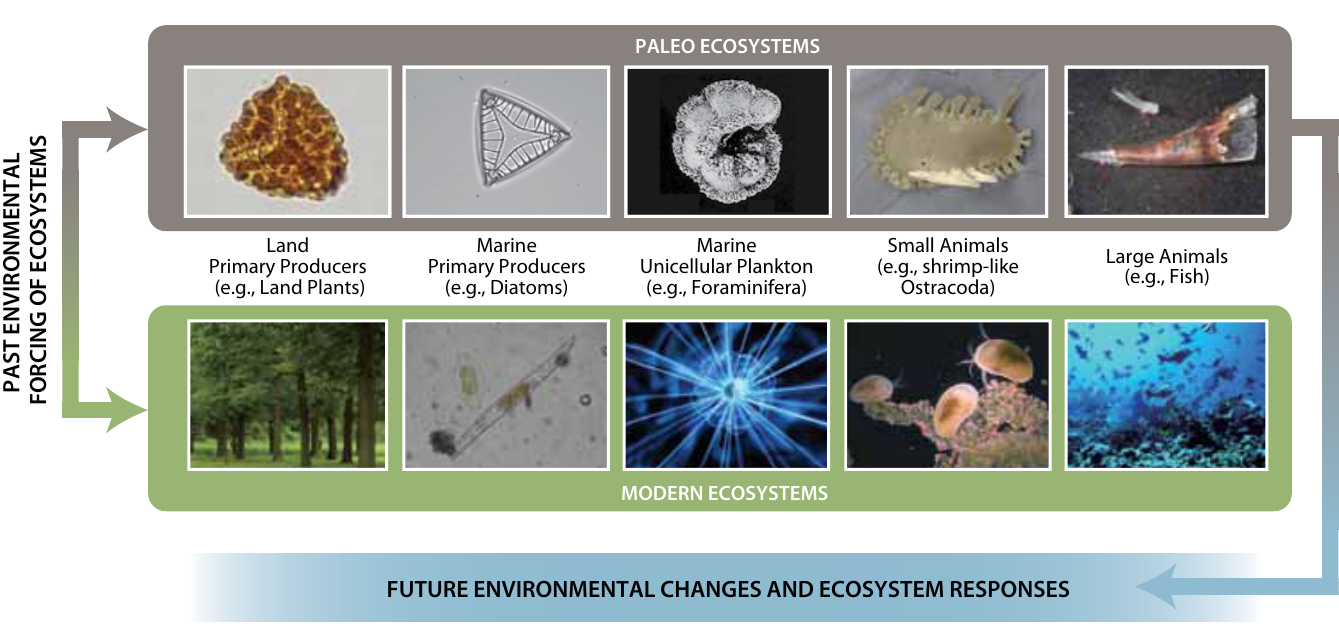
figure 3.7. examples of fossil organisms with an abundant deep-sea fossil record (top row) and living examples of the organisms that produce the fossils (bottom row). left to right: pollen (land plant), diatom (photosynthetic algae), foraminifera (single-celled heterotroph organism), ostracod (small benthic animal), fish. The abundance and diversity of these fossils represent all levels of the food chain, permit detailed reconstruction of oceanic eco- systems, and provide important information about land ecosystems. in addition, the chemical composition of the fossils directly records environmental conditions, such as seawater temperature, salinity, and oceanic productivity. credits: (top, left) iwai et al. (2001); (top, second from left) courtesy of J. Barron, Usgs; (top, middle) olsson et al. (1999); (bottom, second from left) from http://arch.ced.berkeley.edu/hiddenecologies/?page_id=170; (bottom, middle) courtesy of h. spero, University of california,